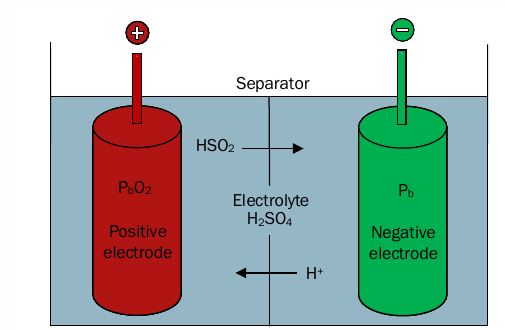
Figure 1. Typical configuration of a lead-acid